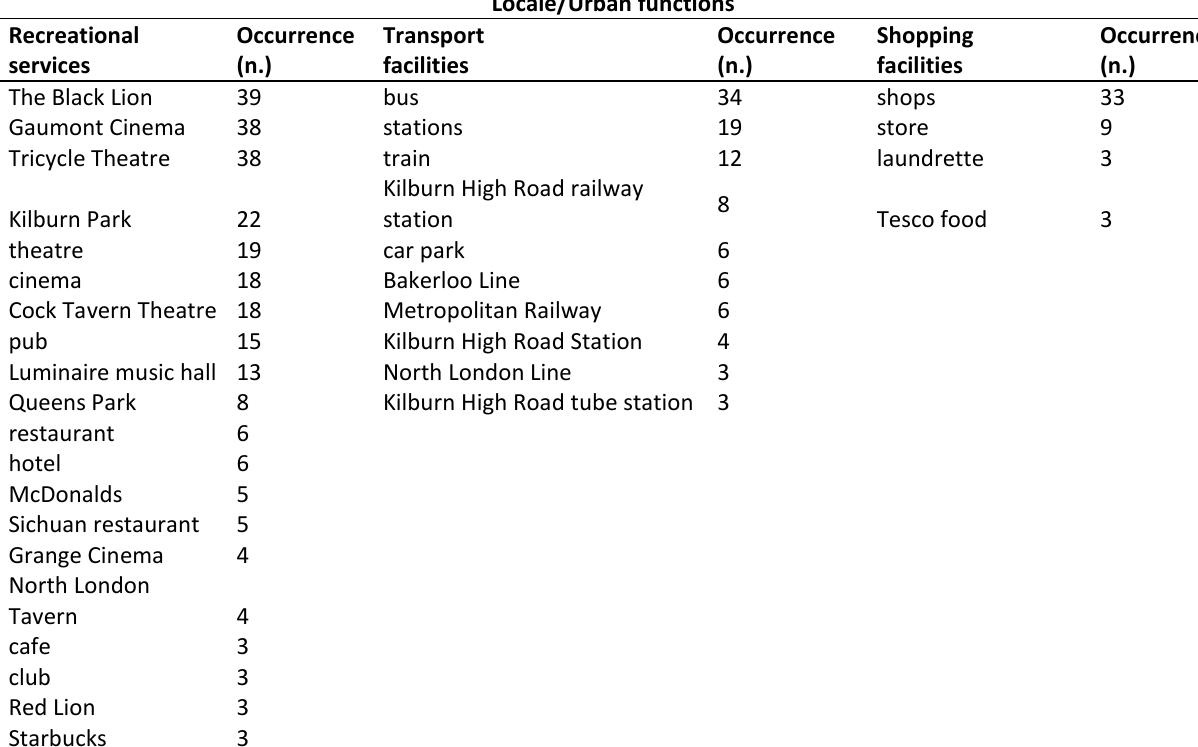
Table 3. Most frequently recurring terms in the urban functions